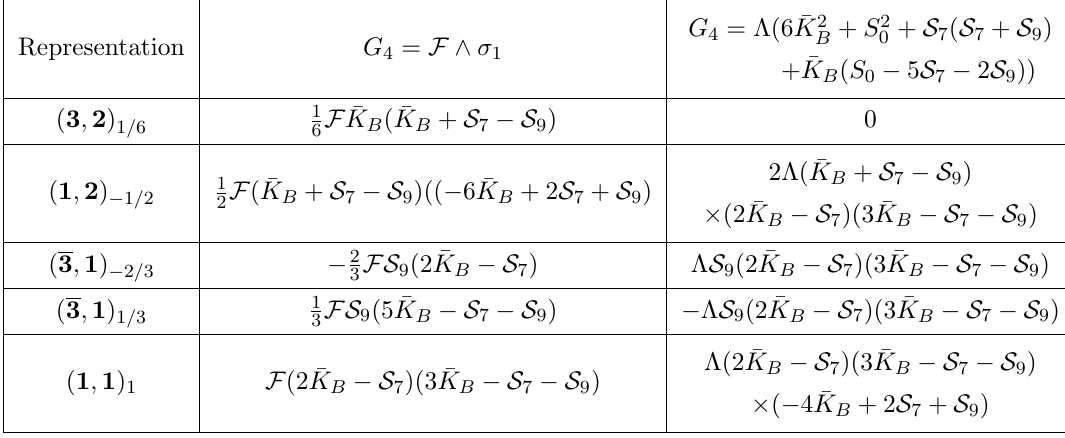
Table 2 . Chiralities for the charged matter in the F 11 model over a generic base. It is understood that the triple intersection numbers are to be computed over the base B 3